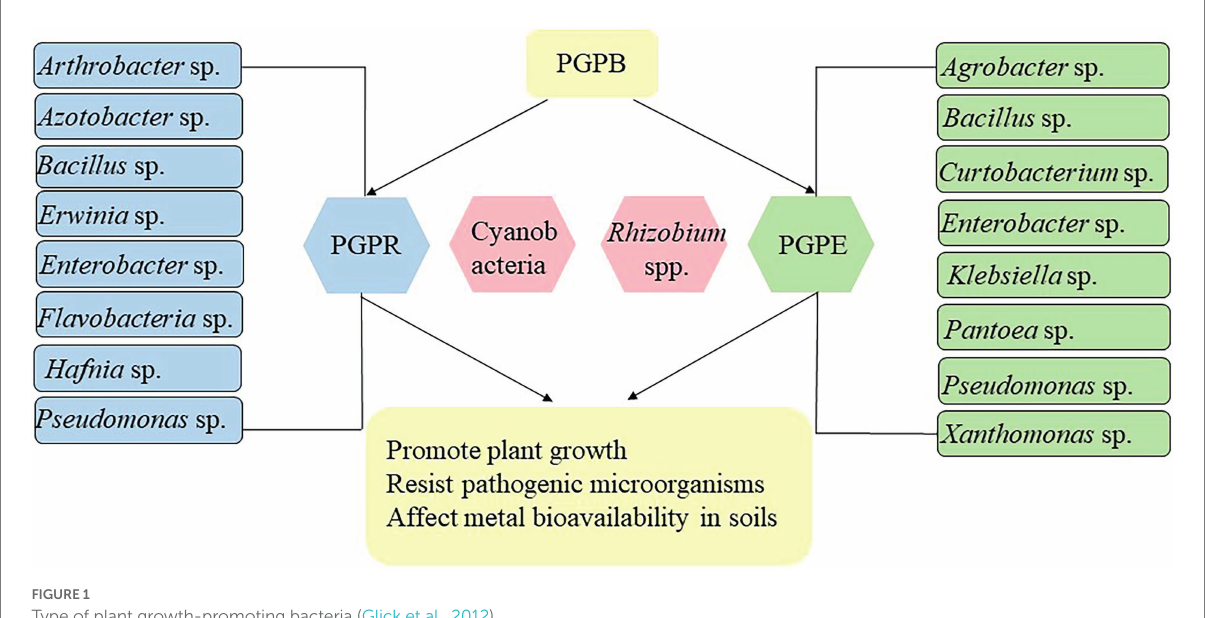
FIGURE 1 Type of plant growth-promoting bacteria (Glick et al.,